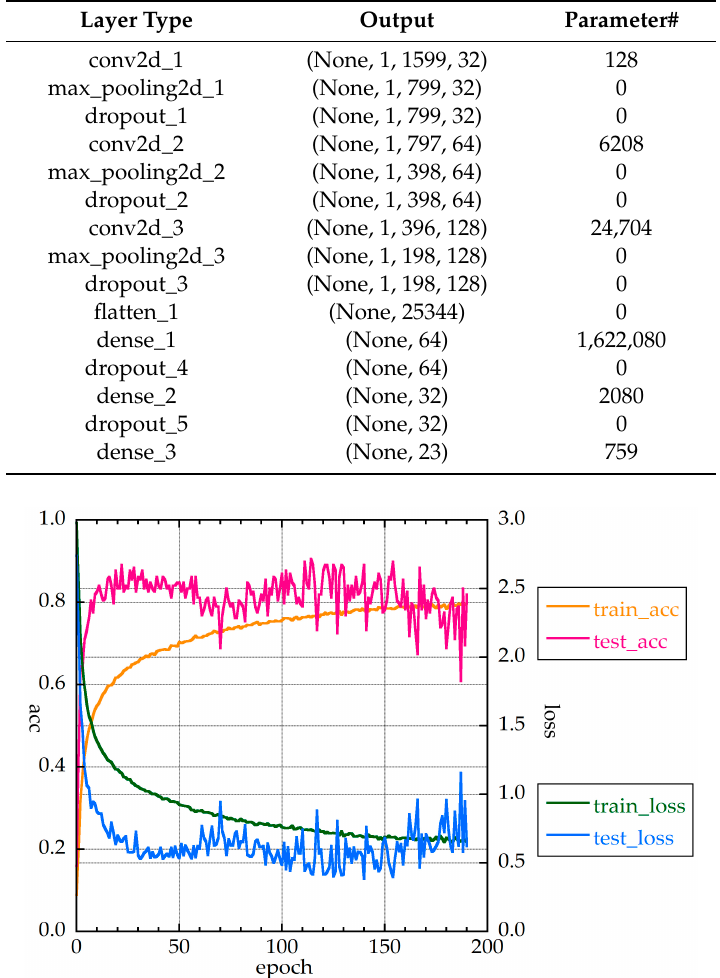
Table 3. The layer structure of CNN1d for 30 measurements.